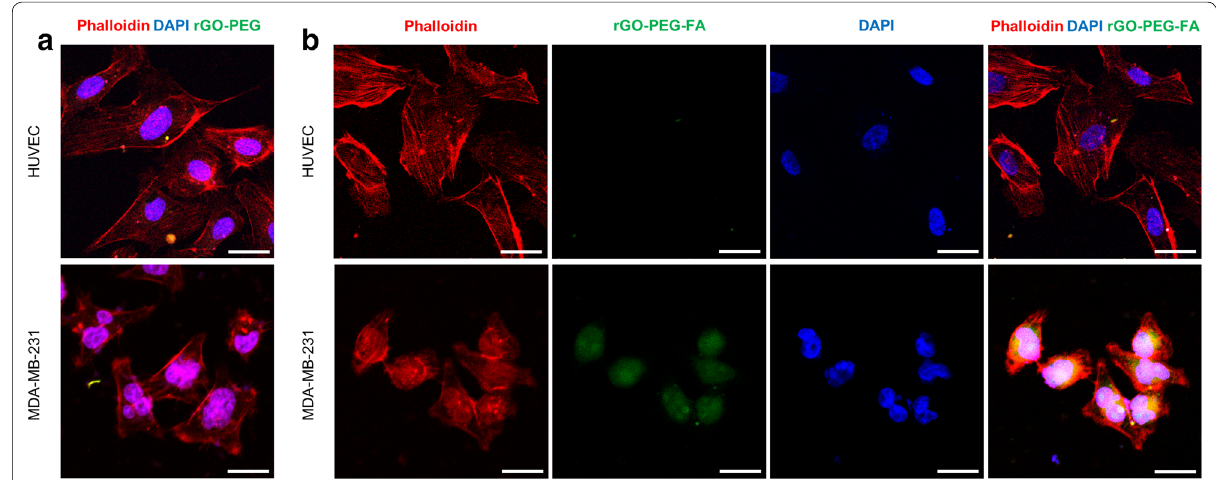
Fig. 3 Confocal laser scanning microscopy images of HUVECs and MDA‑MB‑231 breast cancer cells treated with 30 μg/mL of rGO‑PEG ( a ). Confocal laser scanning microscopy images of cells treated with 30 μg/mL of FA‑conjugated rGO‑PEG for targeting of breast cancer cells ( b ). Scale bars are 20 μm